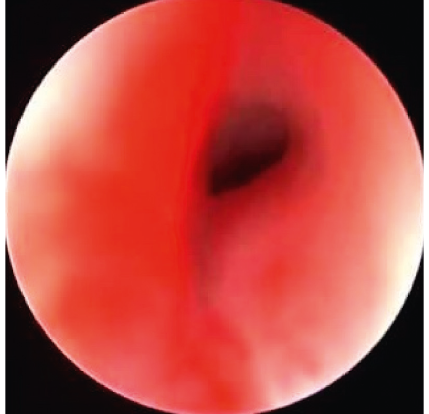
Figure 2: Tracheo-laryngoscopic examination showing subglottic mass obstructing the airway.